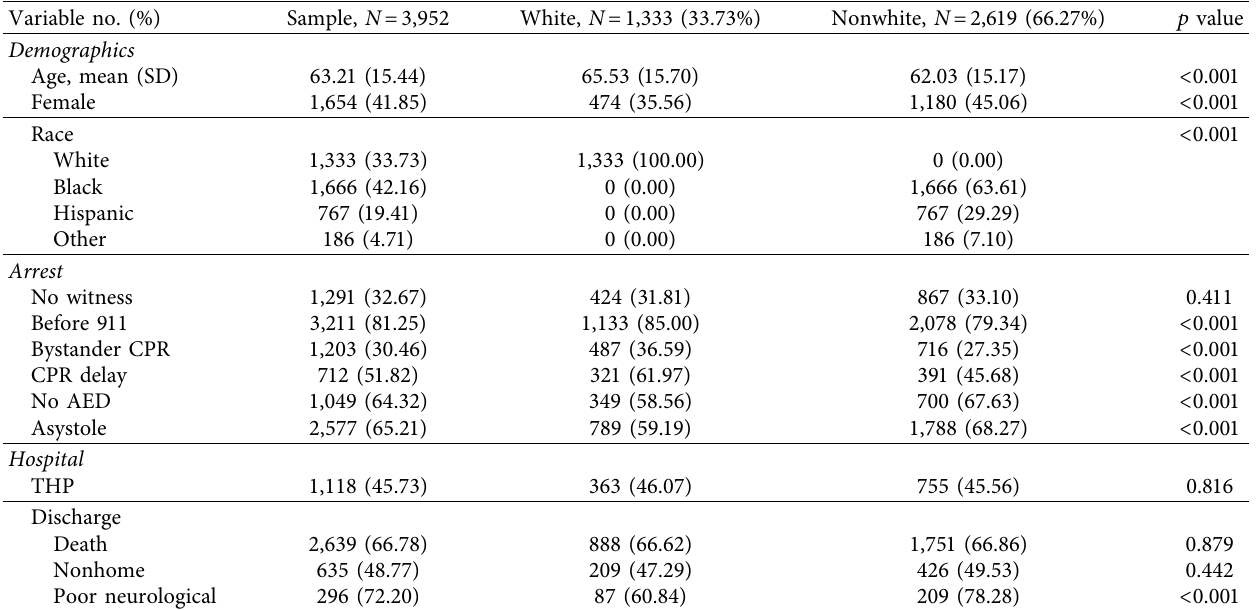
Table 1: Descriptive and bivariable analysis by the nonwhite race in cardiac arrest ( N � 3,952) ∗ . Variable no. (%)